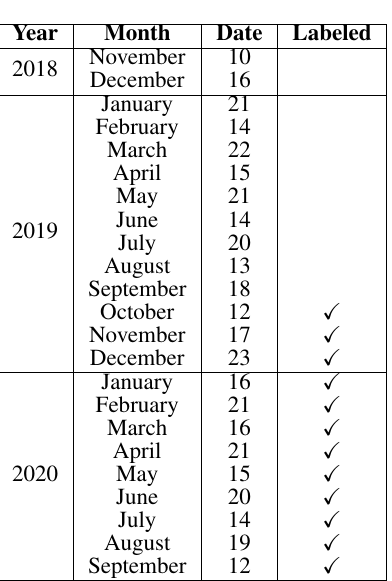
Figure 5. Class percentages per date for (a) LEM 17/18 and (b) LEM 19/20 datasets